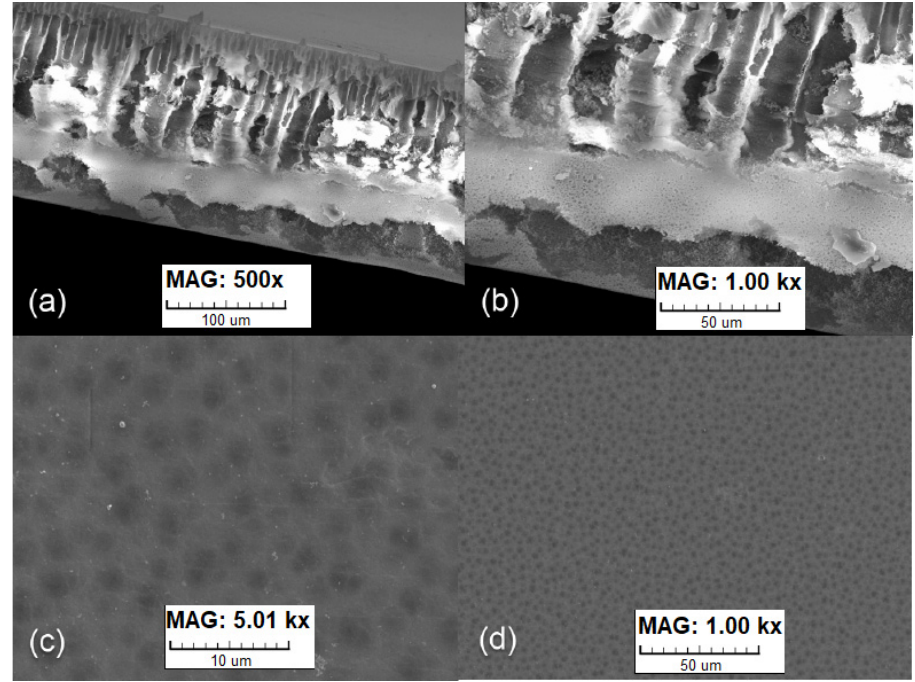
Figure 2. SEM images of cellulose acetate (CA) ( a , b ) membrane cross-section, ( c , d ) membrane surface under 500×, 1000×, and 5000× magnifications.